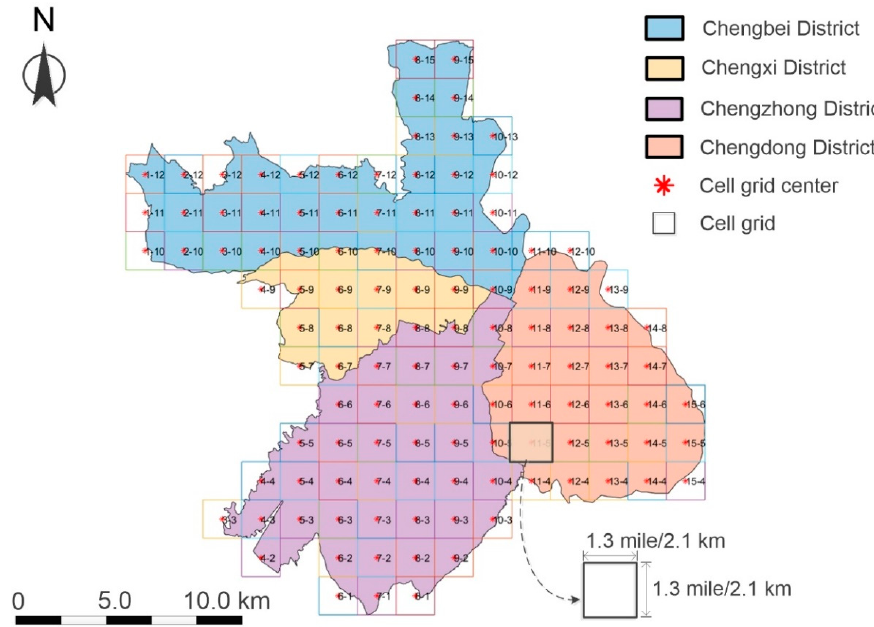
Figure 3. The study area consisting of 118 square-mile cells by quantization. Table 1. Statistics of the defined